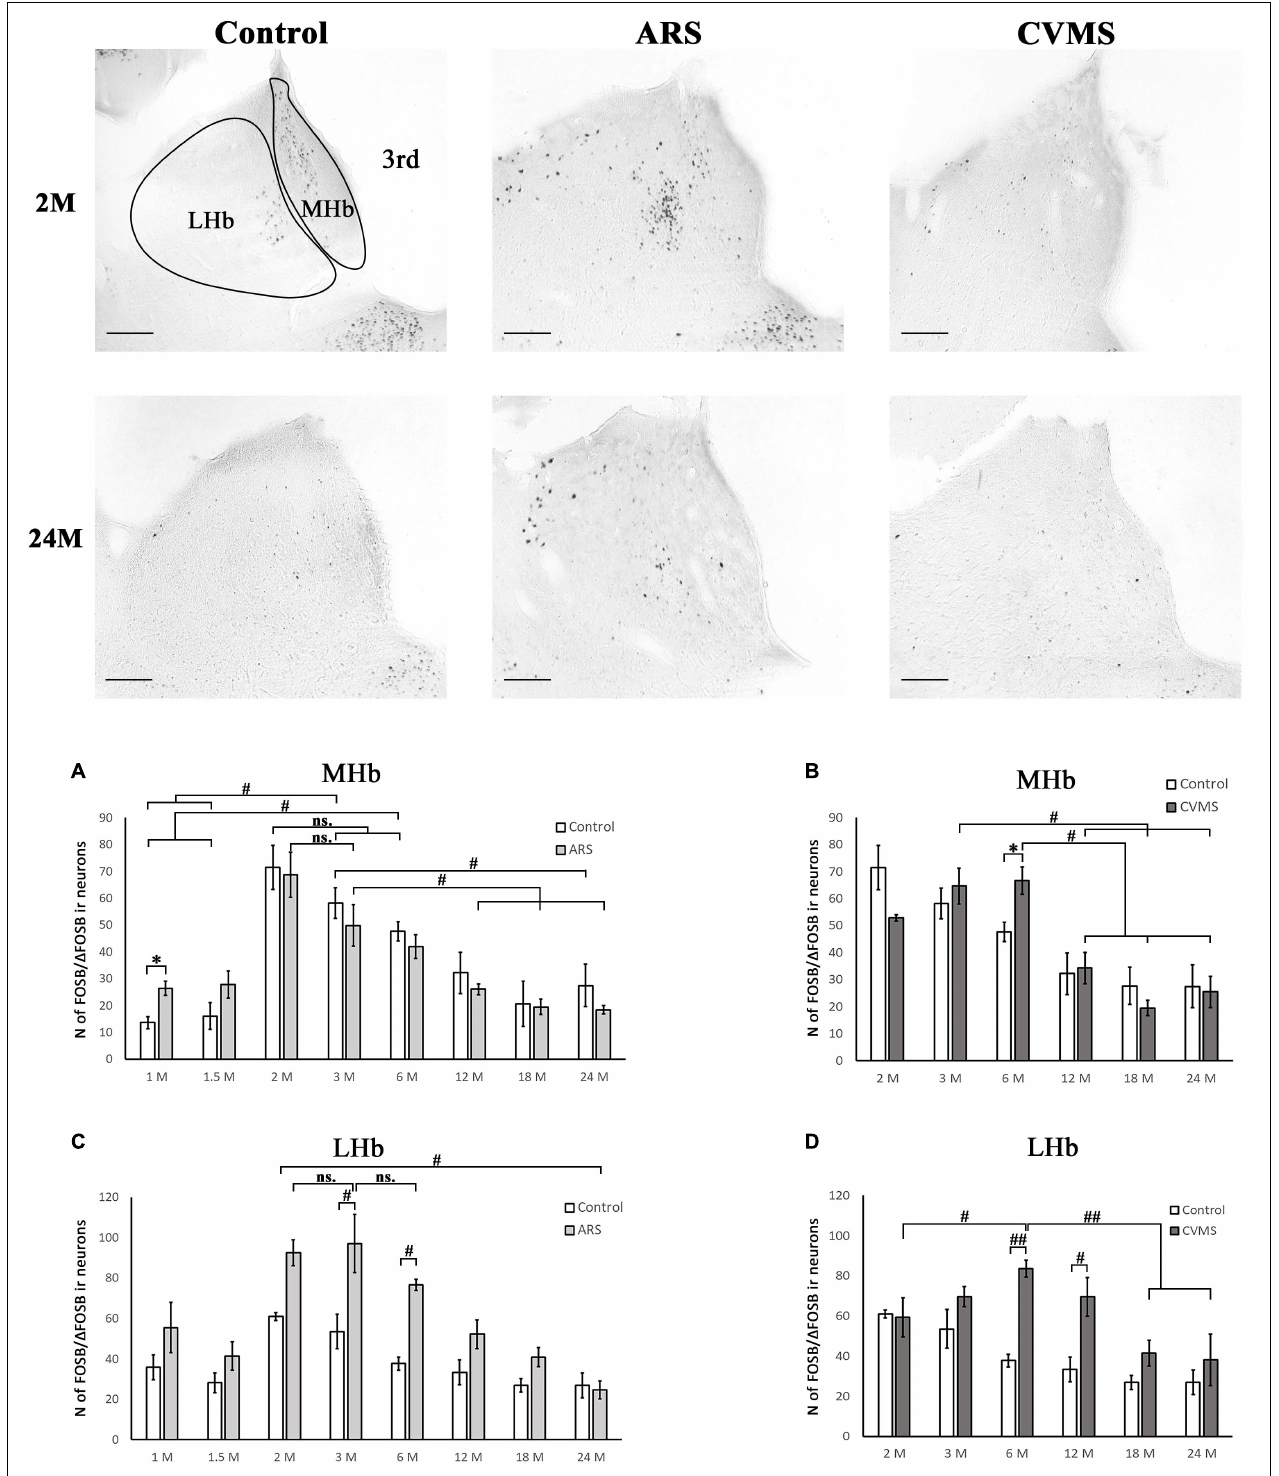
FIGURE 5 | Age-dependent FOSB/ (cid:49) FOSB immunoreactivity (IR) in the medial (MHb) and lateral (LHb) habenula at –3.48 mm to the Bregma. Representative images of 2 and 24-month-old (M) control, acute restraint stress (ARS), and chronic variable mild stress (CVMS)-exposed rats. The number of FOSB/ (cid:49) FOSB IR nuclei was compared among eight age groups in histograms (A,B) for MHb and (C,D) for LHb. Open bars represent the control groups; light gray columns indicate ARS-exposed rats and the dark gray columns show CVMS-exposed rats ( N = 4–7). # p < 0.05, ## p < 0.01 (ns, not significant), according to Tukey’s post-hoc test. ∗ p < 0.05, ∗∗ p < 0.01 according to t -tests. 3rd, third ventricle. Scale bar: 100 µ m.